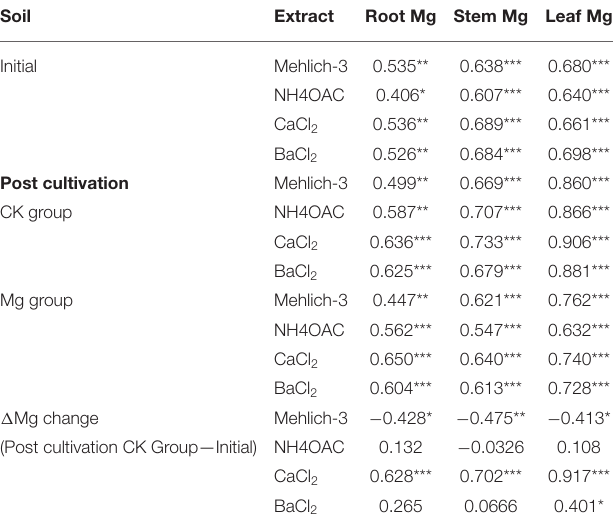
TABLE 2 | Pearson correlation coefficients between soil exchangeable Mg and Mg concentrations in tea plants ( n = 36).